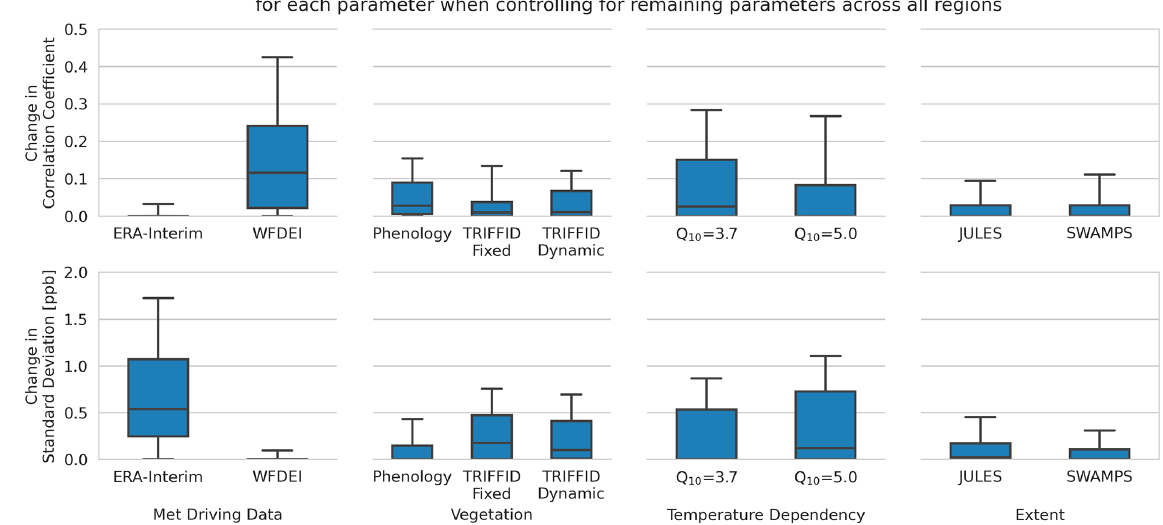
Figure 6. The change in correlation coefficient (top) and standard deviation (bottom) between the JULES ensemble and GOSAT wetland CH 4 seasonal cycle when controlling for the remaining ensemble parameters. The change is the difference above the minimum value for each set of ensemble members. An increased correlation coefficient should be considered an improvement, whereas an increased standard deviation should be considered a deterioration. The changes are calculated for all 16 wetland regions in this study and presented as a box-and-whisker plot (box: quartiles; whiskers: